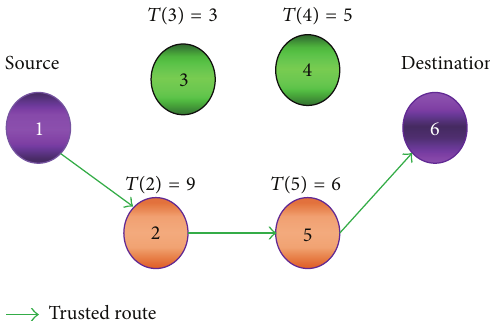
Figure 3: Trust route